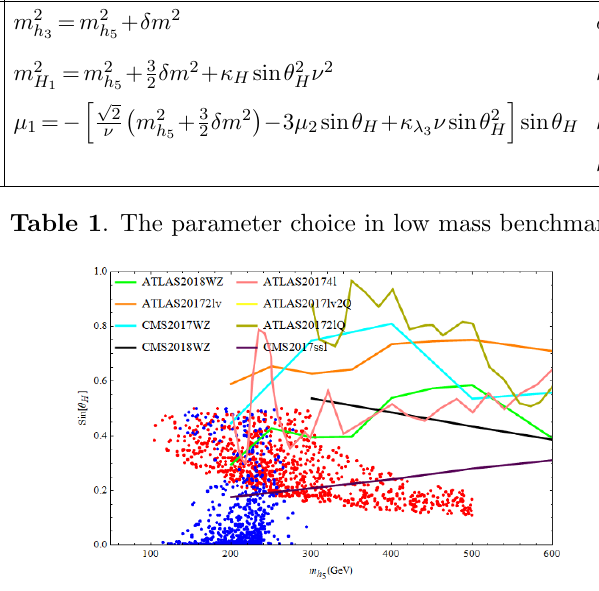
-sin (cid:18) H plane for one step(red) and two-step(blue) 5 5